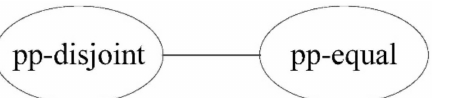
Figure 4. Conceptual neighborhood diagram of topological relations between two